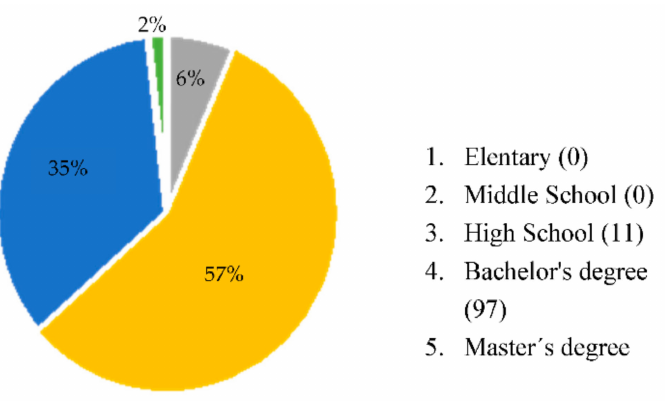
Figure 9. Participation by level of studies. Source: own